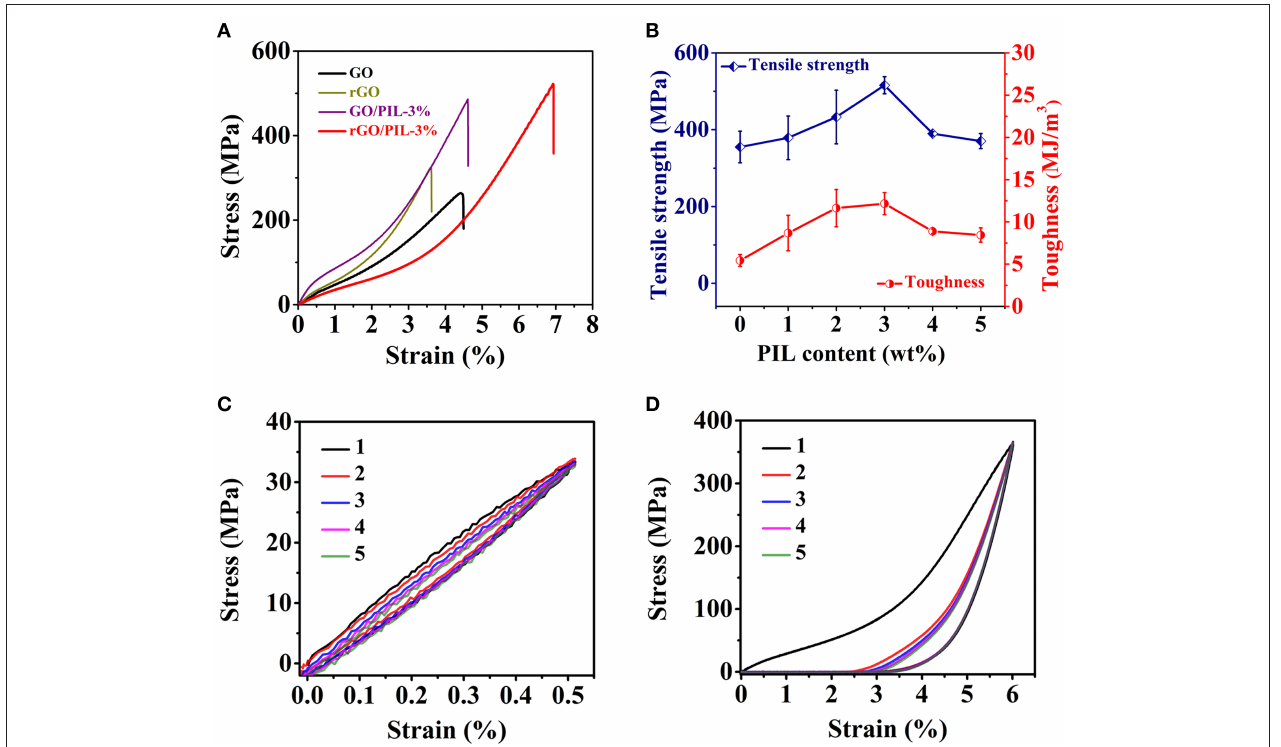
FIGURE 3 | (A) Tensile stress–strain plots of the pristine GO film, rGO film, GO/PIL-3%, and rGO/PIL-3%. (B) The tensile strength and toughness of rGO/PIL- x % with varied PIL contents, x = 0 to 5, rGO/PIL-0% is rGO film. Stress–strain curves of rGO/PIL-3% with strain of 0.5% (C) and 6.0% (D) under five successive loading–unloading cycles. GO, graphene oxide; rGO, reduced graphene oxide; PIL, poly(1-benzyl-3-vinylimidazolium chloride).